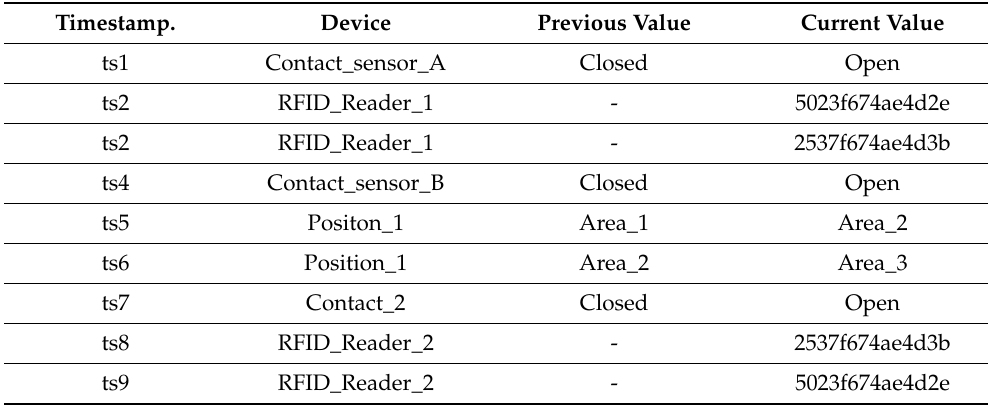
Table 1. Case study observations from